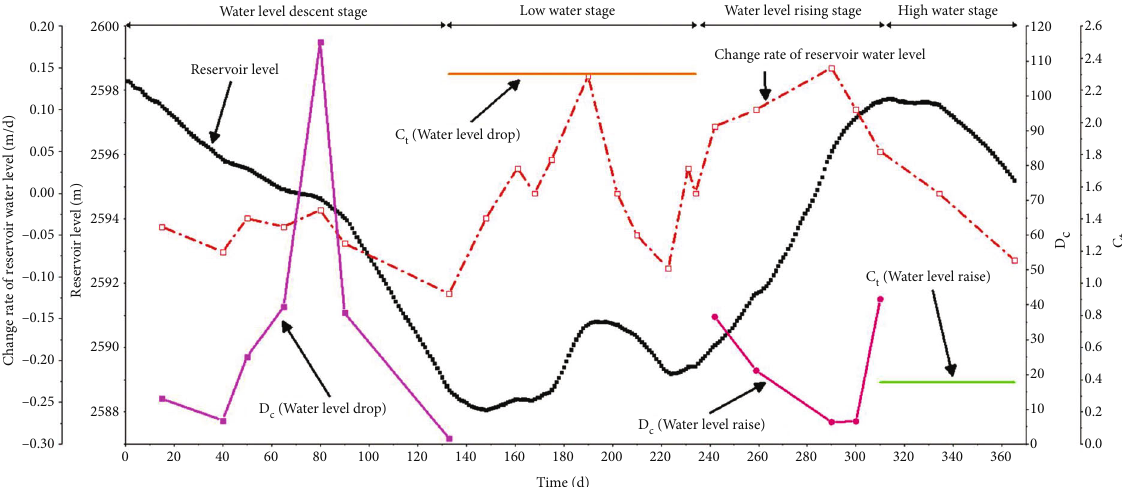
Figure 11: Deformation sensitivity calculation